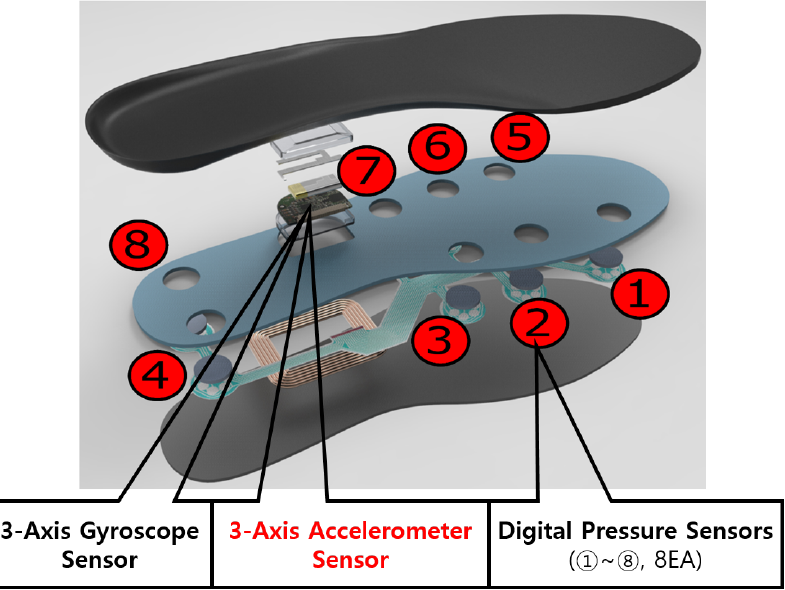
Figure 1. The Footlogger smart